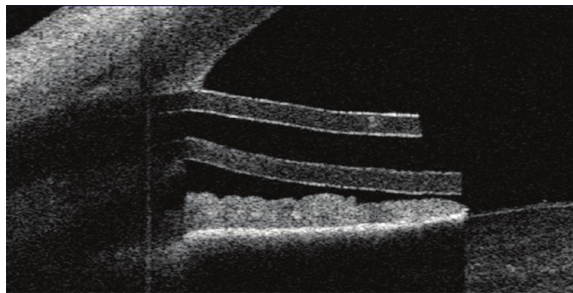
Figure 11: AS-OCT: patent Ahmed gaucoma